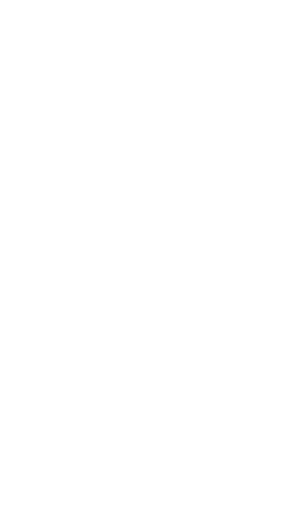
Figure 17. Stress concentration through hull deflection in Model 3.